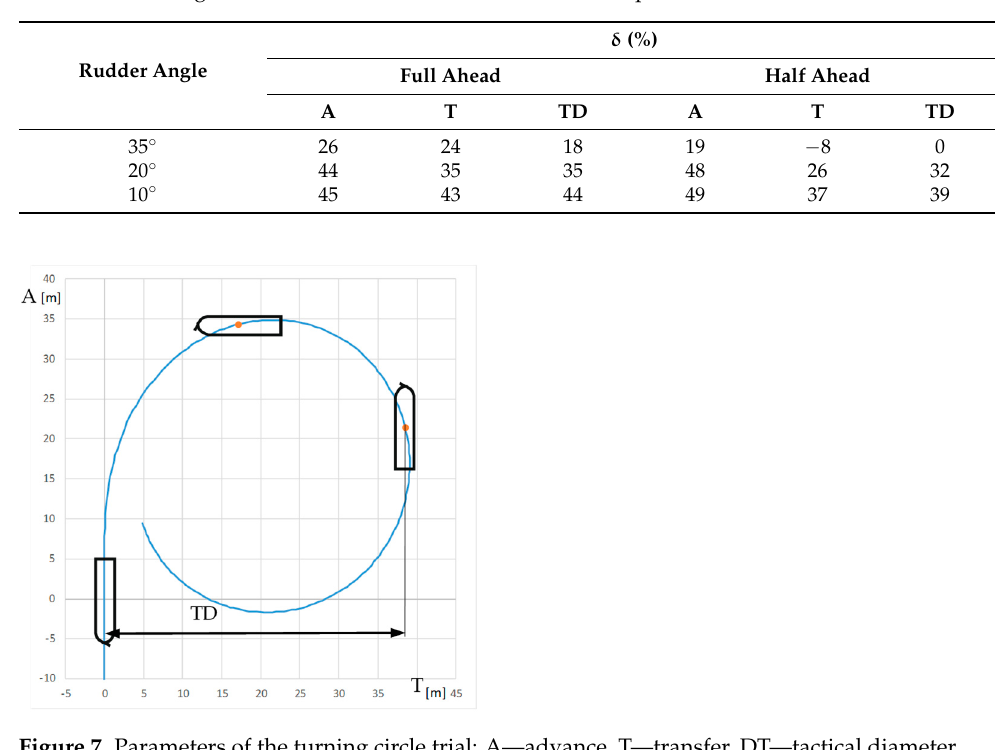
Table 8. Difference between turning circle parameters for two engine settings: Full Ahead and Half Ahead, rudder angles set starboard, and clockwise rotational speeds of RC2 trial.